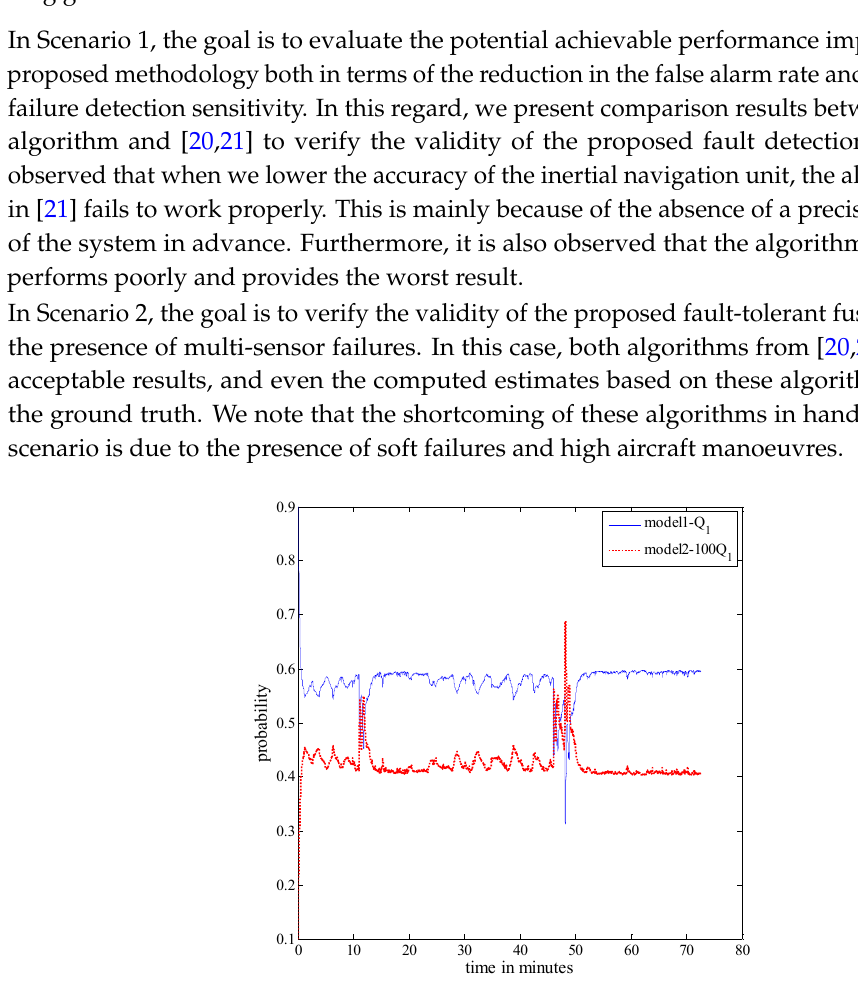
Figure 15. Probability of each